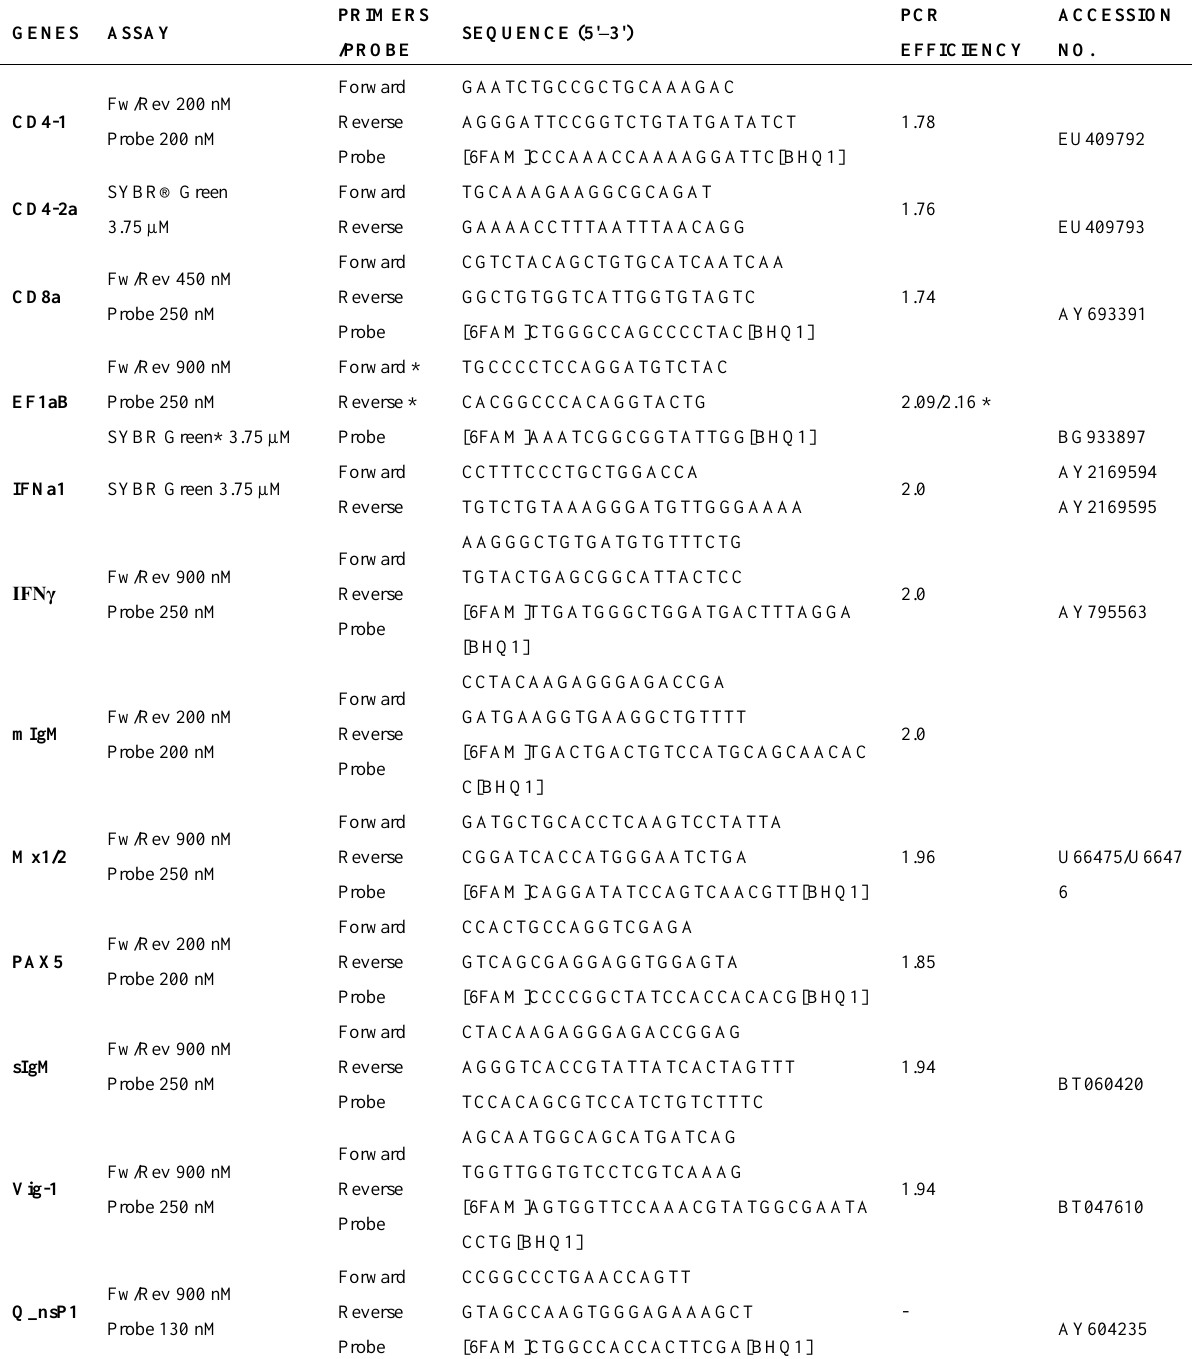
Table 2. Primers and probe sequences for quantitative reverse-transcriptase PCR and PCR